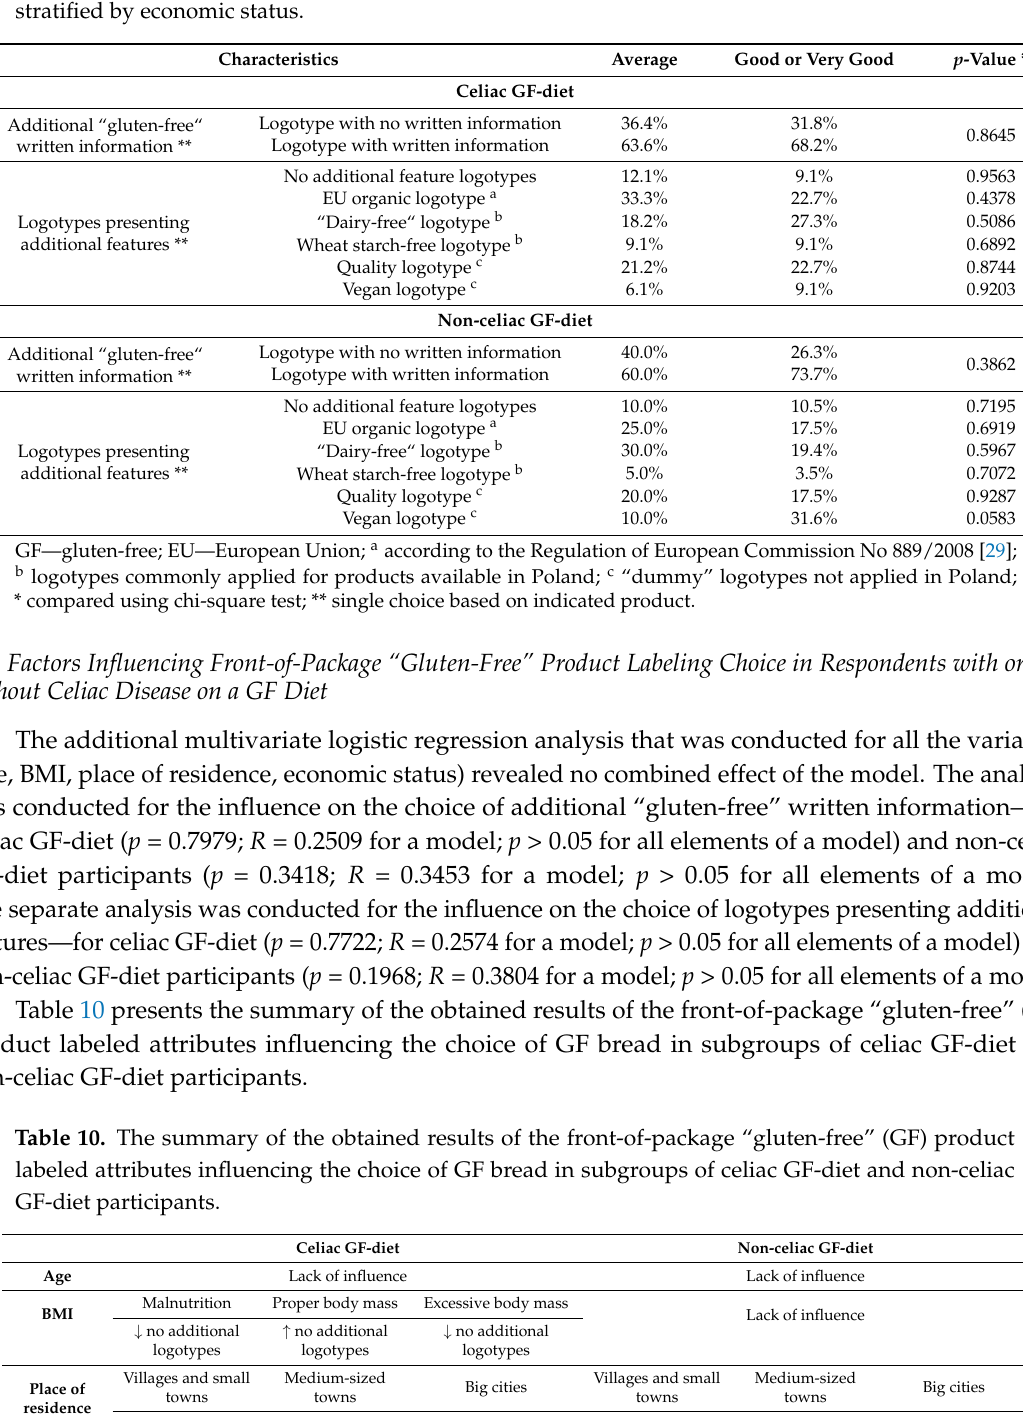
Table 9. The comparison of the front-of-package “gluten-free” (GF) product labeled attributes influencing the choice of GF bread in subgroups of celiac GF-diet and non-celiac GF-diet participants stratified by economic status.